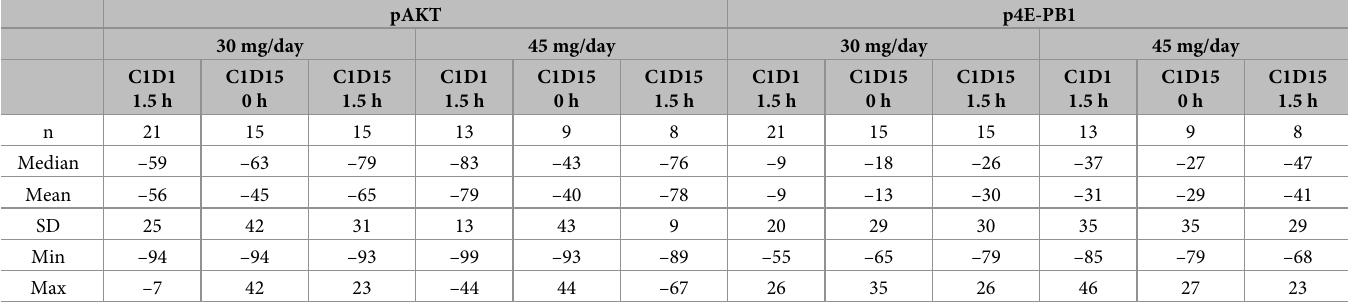
Table 4. Regulation of pAKT and p4E-BP1 in monocytes. Inhibition (percent change from baseline) for pAKT and p4E-BP1 in monocytes of patients initially dosed with 45 mg or 30 mg CC-223.